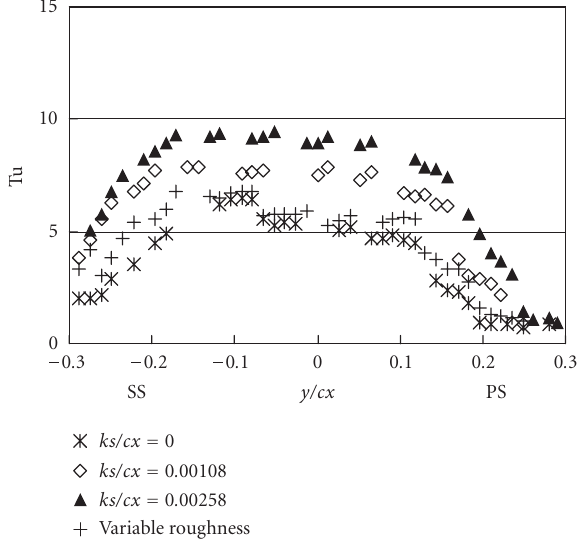
Figure 6: Profiles of turbulence intensity across the wakes measured one axial chord length downstream of the cambered airfoils with di ff erent rough surfaces for Tu = 1 . 1